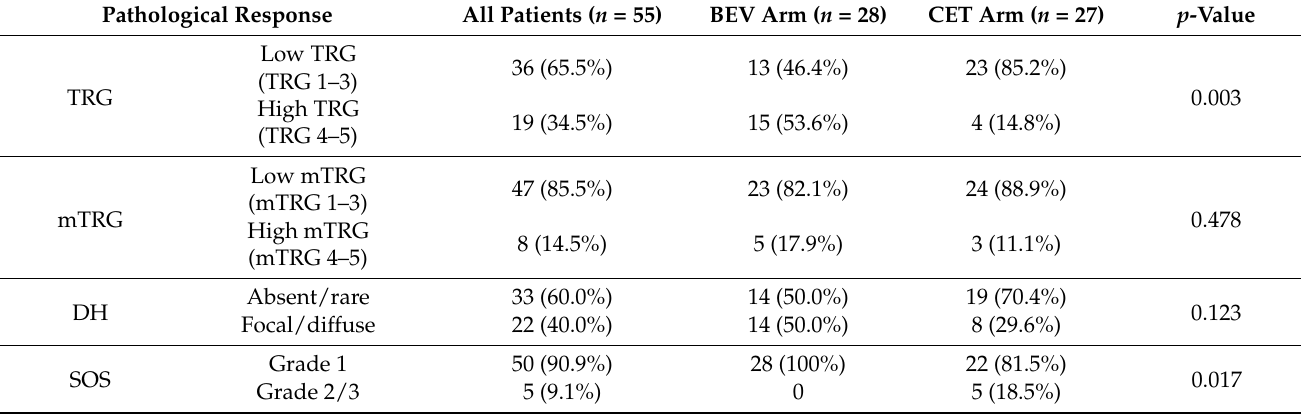
Table 2. Pathological responses of the TRG/mTRG systems and DH/SOS classifications between the BEV and CET